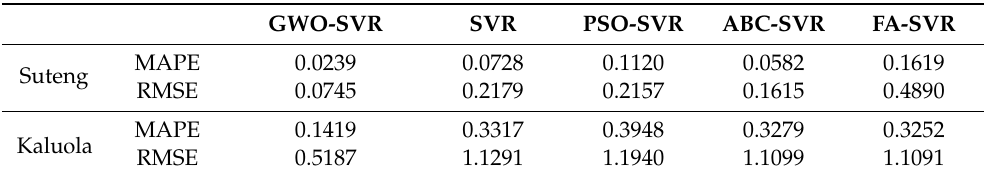
Table 5. Model comparison results.